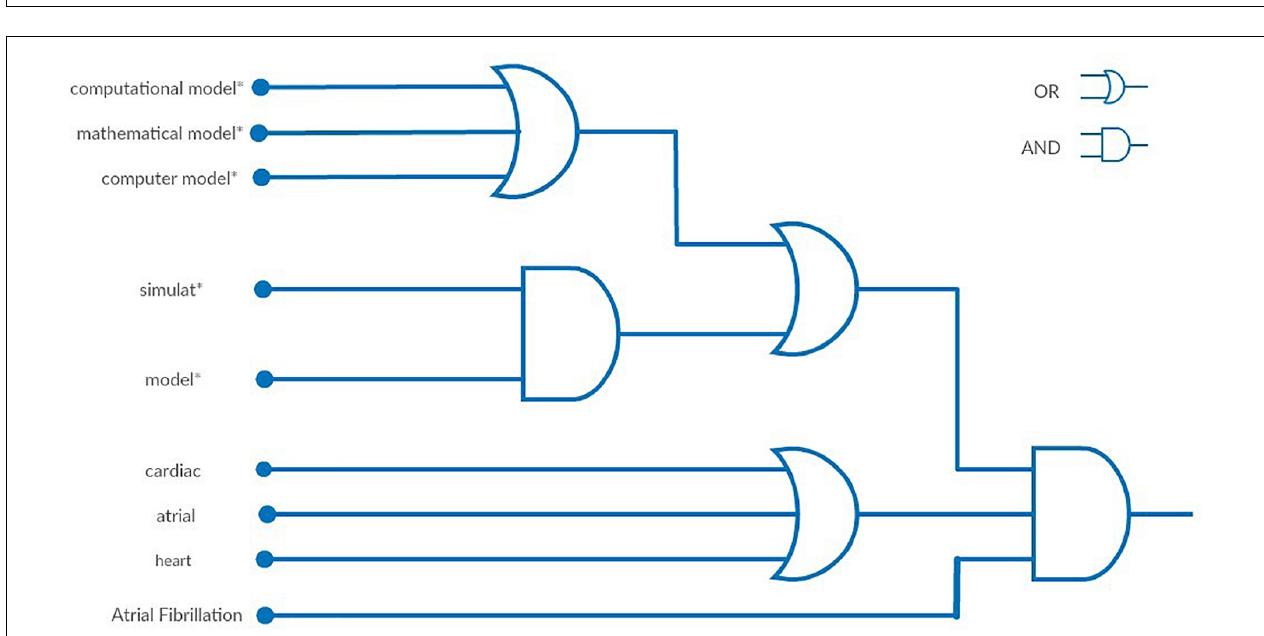
FIGURE 2 | Visual representation of the final query using logic gates. The final query is described as: {[(“computational model ∗ ”[Title/Abstract] OR “mathematical model ∗ ”[Title/Abstract] OR “computer model ∗ ”[Title/Abstract]) OR (simulat ∗ [Title/Abstract] AND model ∗ [Title/Abstract])] AND (“cardiac”[Title/Abstract] OR “atrial”[Title/Abstract] OR “heart”[Title/Abstract])} AND “atrial fibrillation”[Text Word].